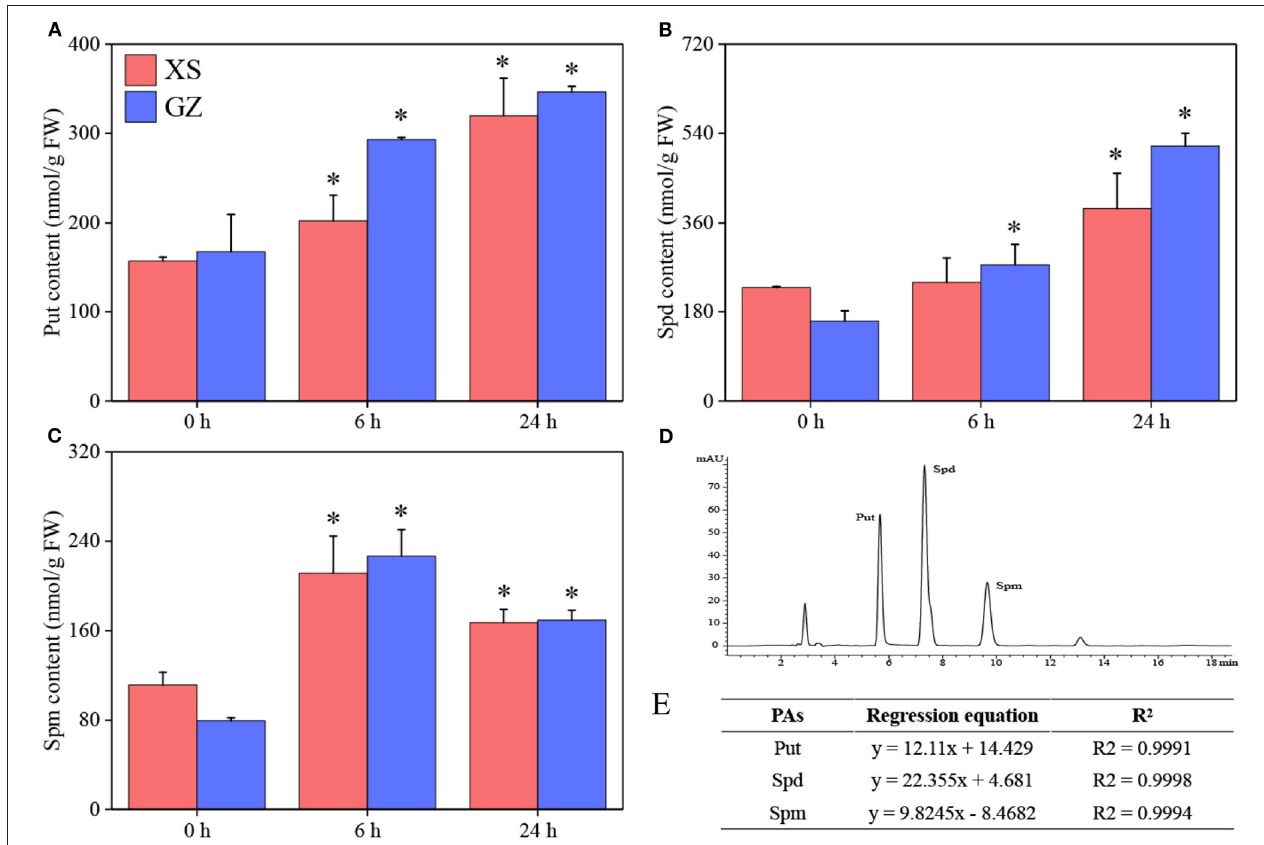
SUPPLEMENTARY FIGURE 6 | Determination of PAs contents in XS and GZ under cold stress. (A) Put content. (B) Spd content. (C) Spm content. (D) Chromatogram of mixed standard solution of PAs. (E) The regression equation and correlation coefficient of PAs.